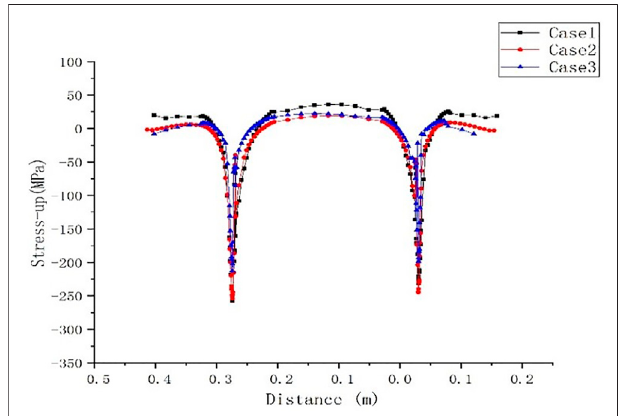
FIGURE 7 | Residual stress σ x along the x -direction (t1 = 6 mm).